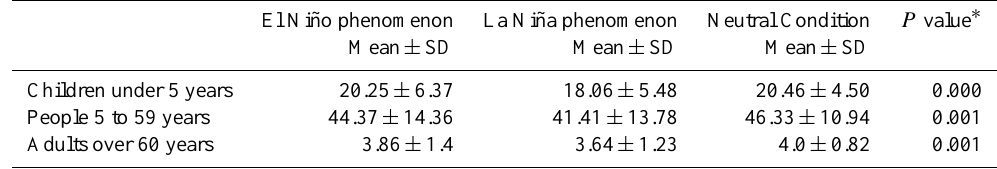
Table 1. Description of diarrhoea diseases by age and El Niño, La Niña and neutral from 2000 to 2010.